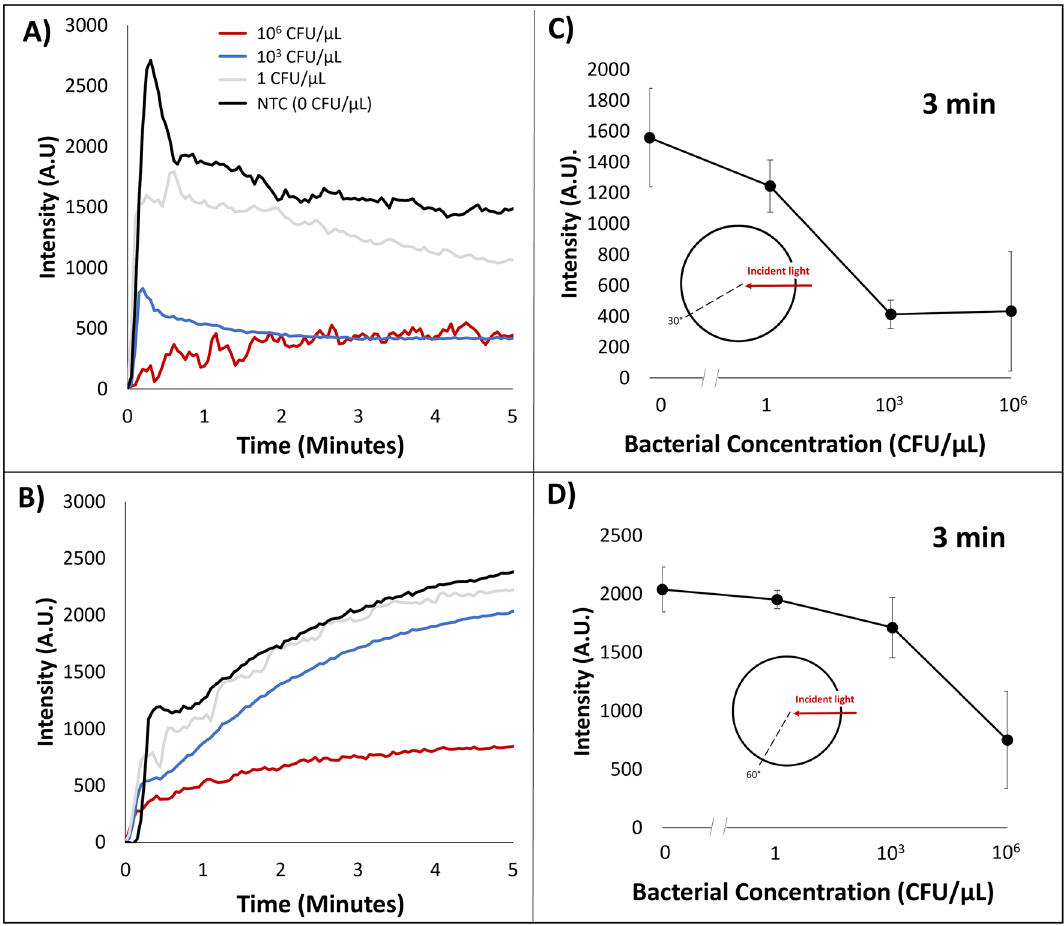
µL. ( A and B ) are the representatives chosen from 3 replicates for each concentration. Light scatter intensity at 3 min for ( C ) 30° and ( D ) 60° angle for bacteria concentrations of 10 6 , 10 3 , 1, and 0